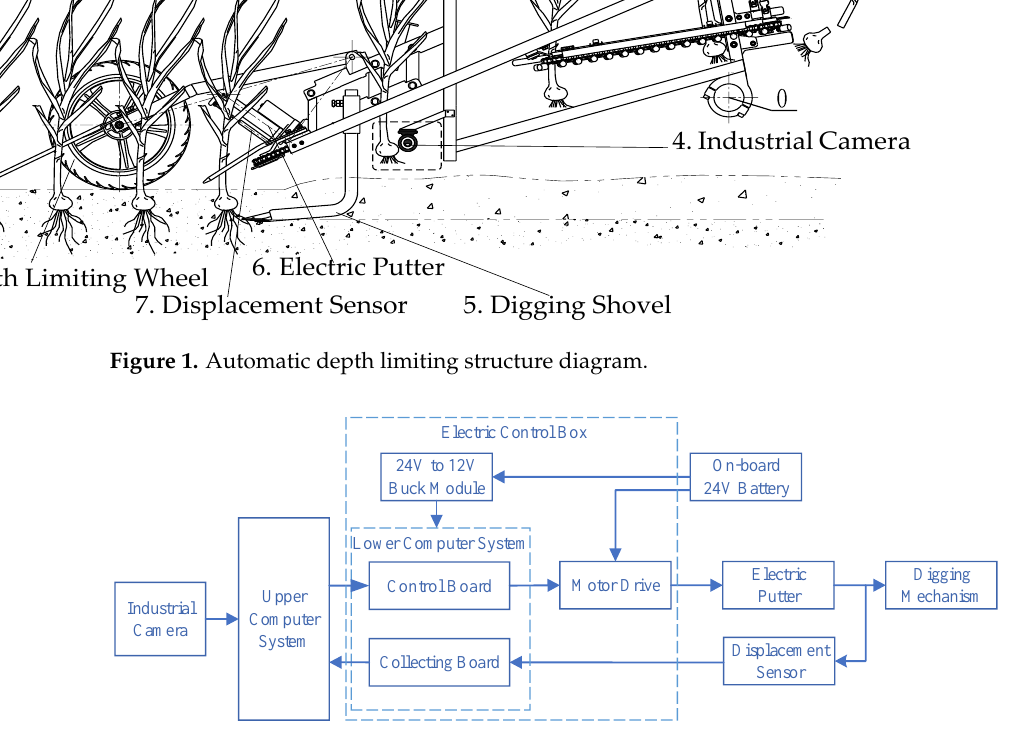
Figure 2. The working principle of the automatic control system of digging depth.